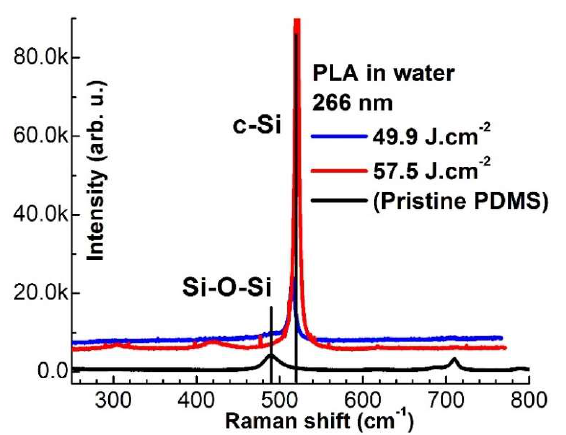
Figure 9. Raman spectra of PDMS polymer processed by 266 nm laser pulses in a water environment. Similar Raman spectra are obtained after processing with 366 nm. The Raman spectra demonstrate chemical activation of the surface after UV laser treatment with all fluences applied.